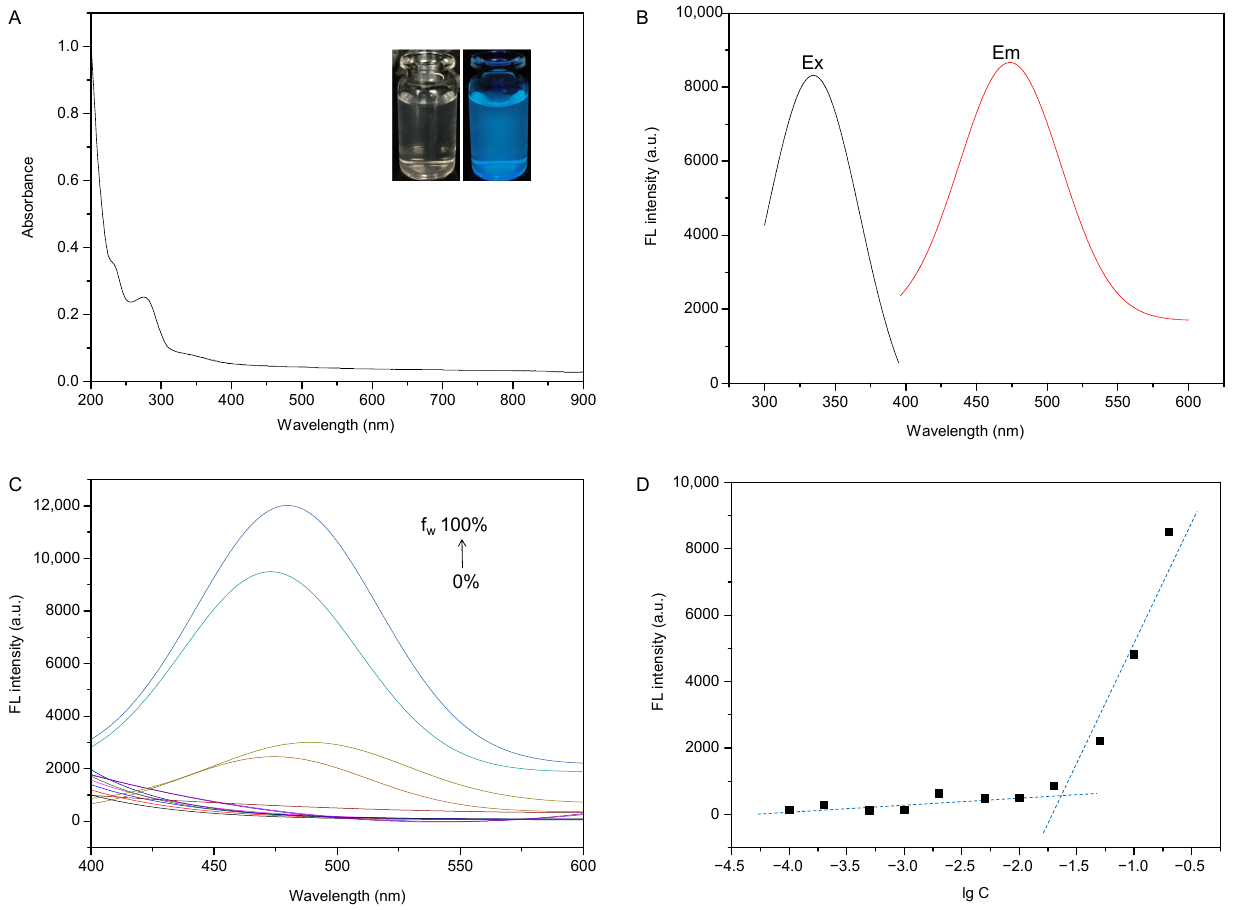
Figure 2. Optical properties of Bi(mPEG-S-S)-TPE. ( A ) UV–Vis spectrum of Bi(mPEG-S-S)-TPE in water. Insets are photographs of Bi(mPEG-S-S)-TPE aggregates in water (left: exposure to a daylight lamp; right: exposure to a UV lamp at 365 nm). ( B ) Excitation and emission spectra of Bi(mPEG-S-S)-TPE in water. ( C ) Fluorescent spectra of Bi(mPEG-S-S)-TPE in THF–water mixtures. ( D ) Relationship between FL intensity and the logarithm of Bi(mPEG-S-S)-TPE concentration. For TPE display AIE behavior [31], the polymer Bi(mPEG-S-S)-TPE would exhibit an AIE effect in aggregated state. The AIE feature of Bi(mPEG-S-S)-TPE was studied in the mixtures of tetrahydrofuran (THF) and water with different water fractions (f w ). As